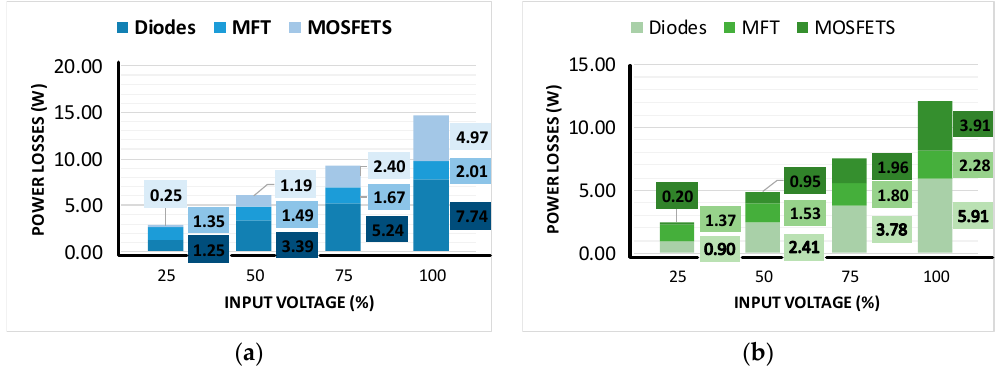
Figure 9. Loss percentages in ( a ) 2L and ( b ) 3L converters.